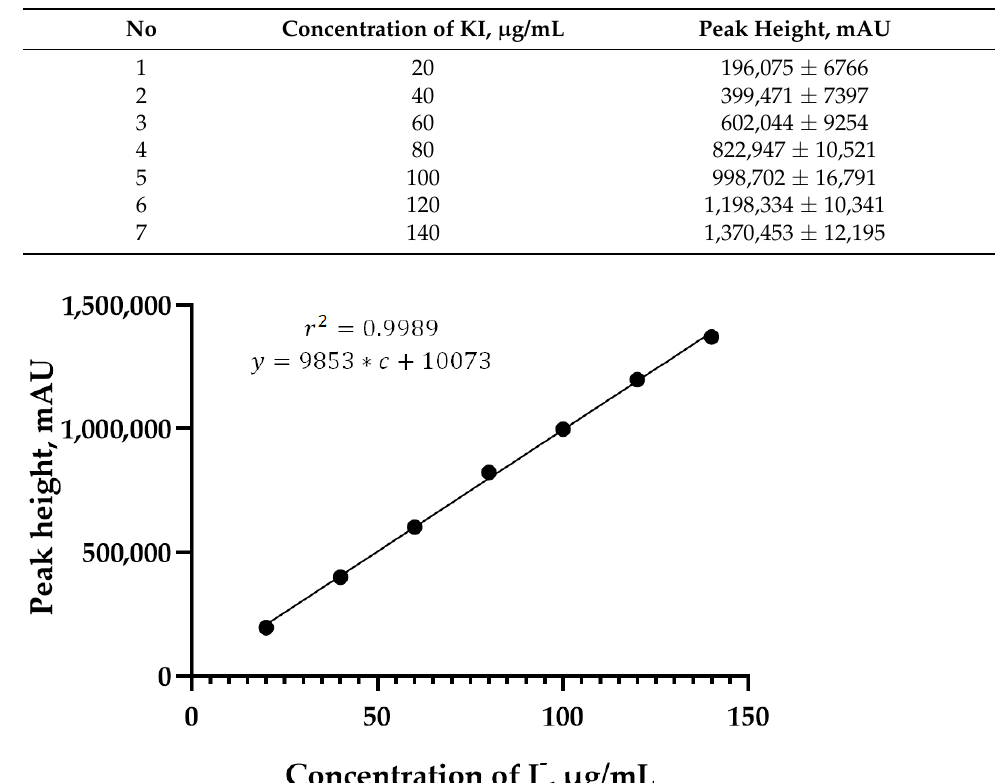
Table 3. Results of linearity analysis.